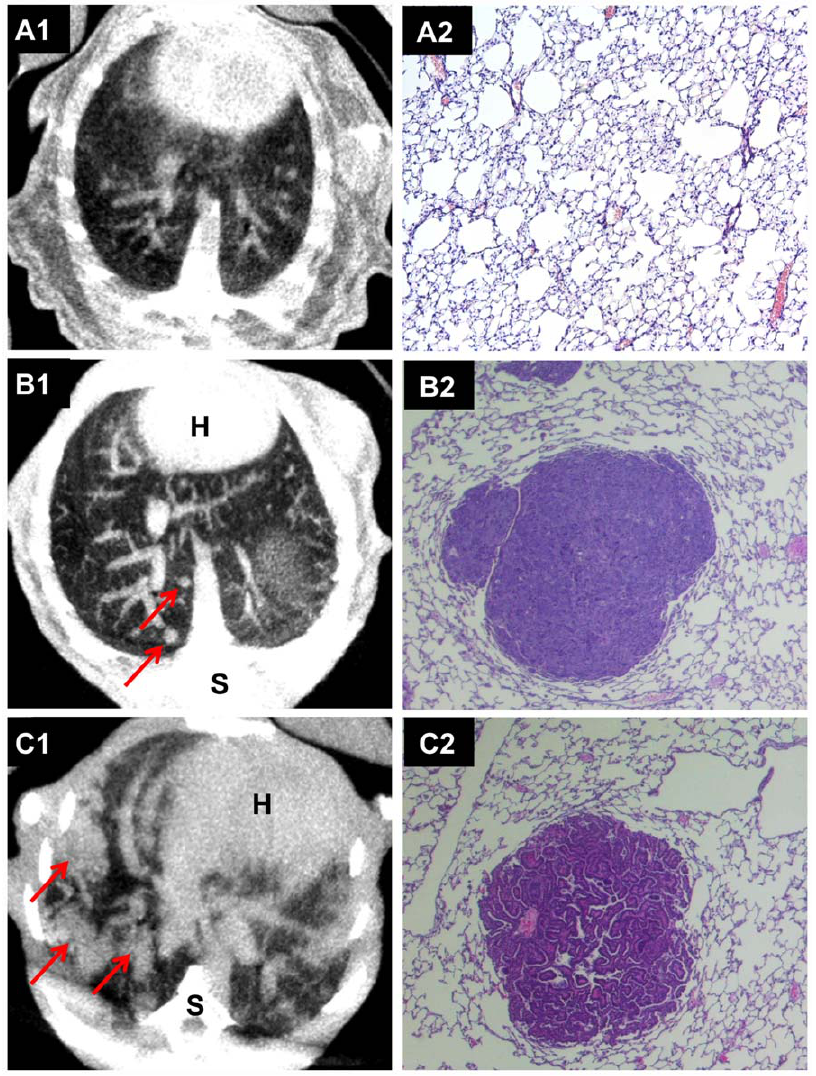
Figure 7. CT and histopathology of the lung of NDEA treated c-Myc transgenic mice. (A) Normal lung parenchyma of a vehicle treated control animal as shown by CT (A1) and by histopathology (A2). CT of NDEA treated animals at the age of 8.5 months. Depicted are lung nodules of different size (red arrows). Histopathology evidenced those lung nodules as metastasis of a poorly differentiated HCC (B2) and as well adenocarcinoma of the lung (C2).